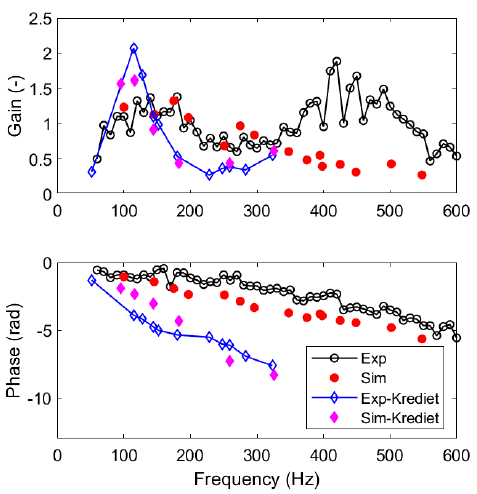
Figure 10. Flame transfer function comparison for this study and Krediet’s study.